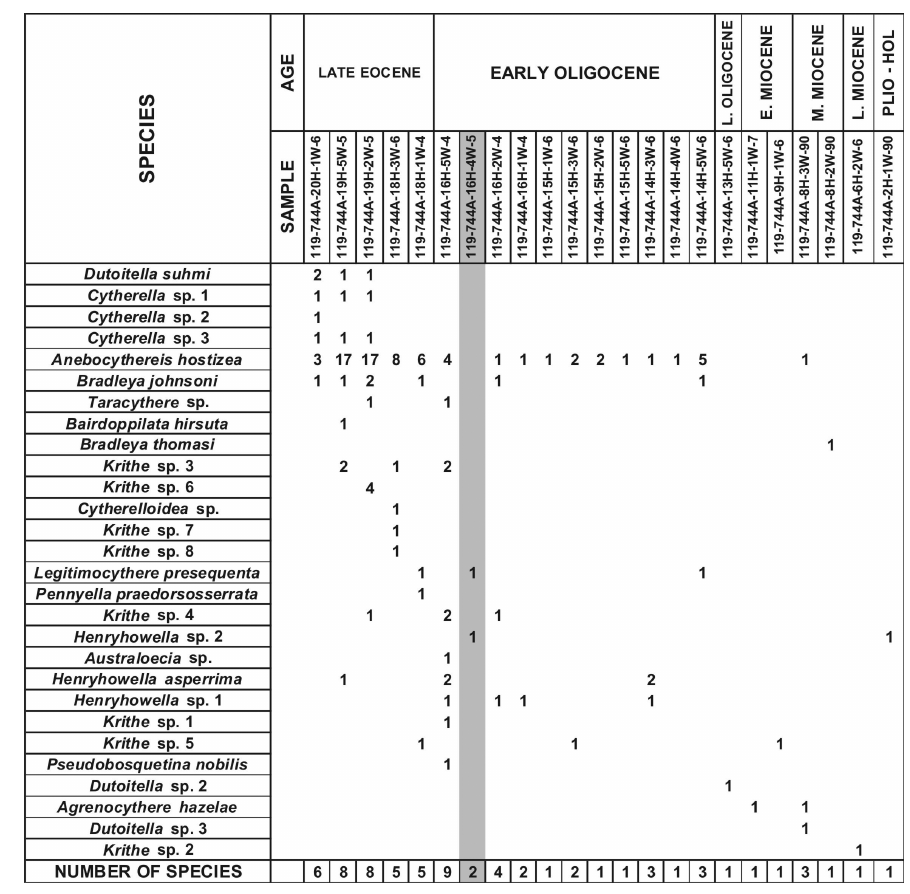
Fig. 2 – Occurrence and abundance of species in the samples studied. The shadowed column refer to the faunal